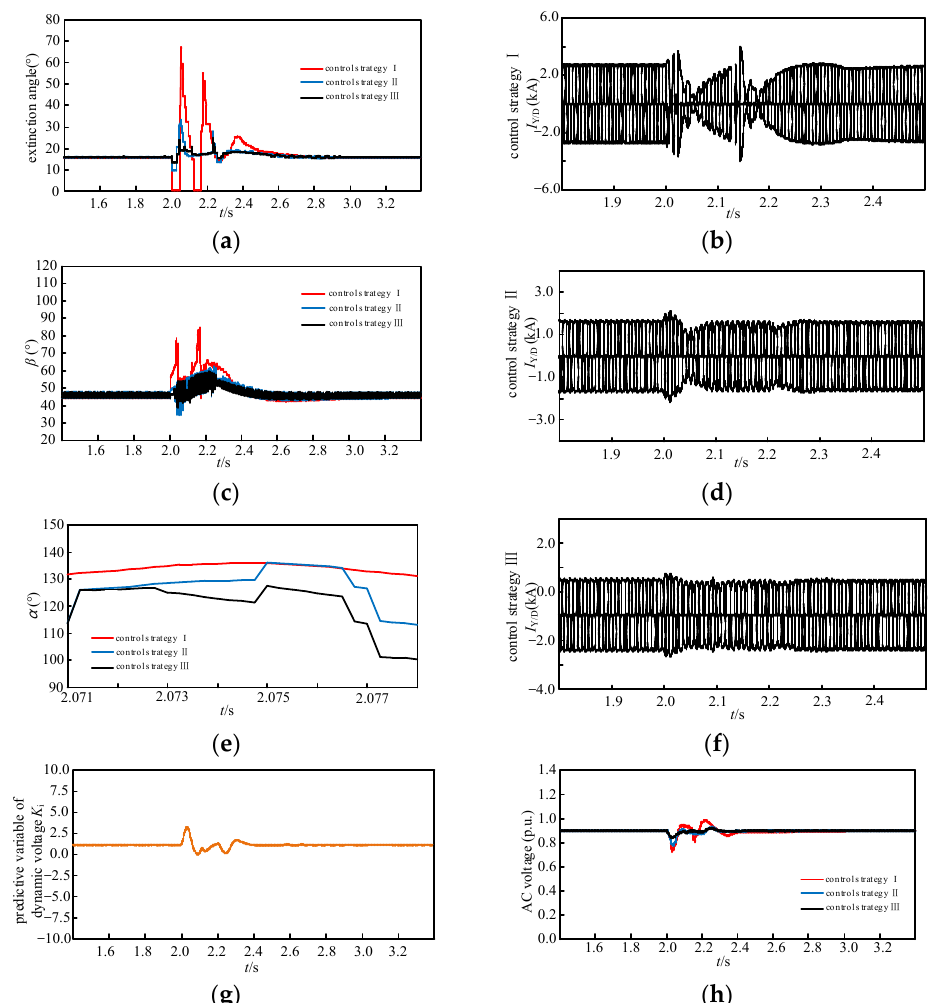
Figure 11. Waveforms of three-phase short-circuit fault under different strategies. ( a ) Extinction an- gle γ under three strategies. ( b ) Current at valve side of converter transformer under strategy Ⅰ . ( c ) Trigger advance angle β under three strategies. ( d ) Current at valve side of converter transformer under strategy Ⅱ . ( e ) Trigger delay angle α under three strategies. ( f ) Current at valve side of con- verter transformer under strategy Ⅲ . ( g ) Predictive variable of dynamic voltage K i . ( h ) AC voltage at inverter side.